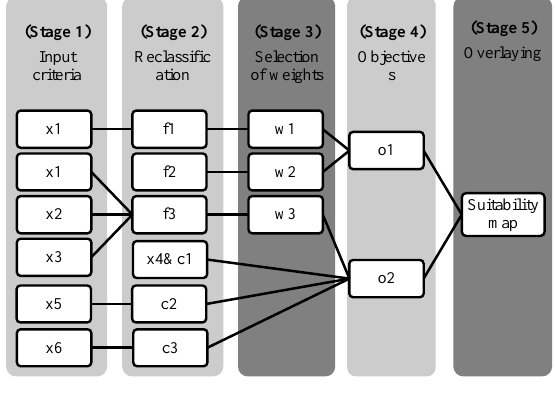
Figure 1. General stages of the GSS